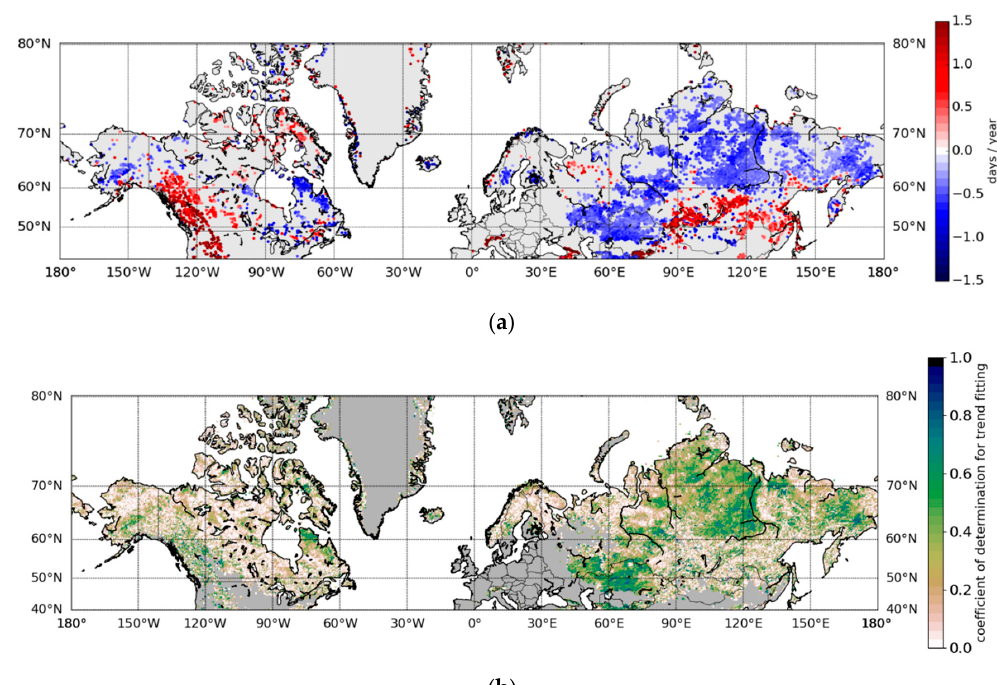
Figure 9. ( a ) The rates of change for the end date of melt between 1982 and 2015 using 5-year rolling mean (showing cases for which R 2 of the fit was larger than 0.5). The negative rates of change mean earlier end of melt and the positive rates of change mean later dates of end of melt. ( b ) The coefficient of determination ( R 2 ) values for the trend fitting for end day of melt.